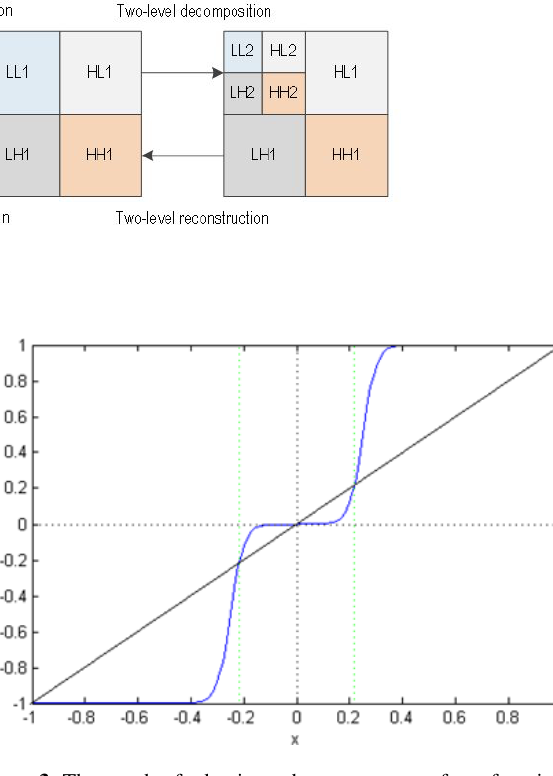
Figure 3. The graph of adaptive enhancement transform function, in which b = 0 . 25 and c =